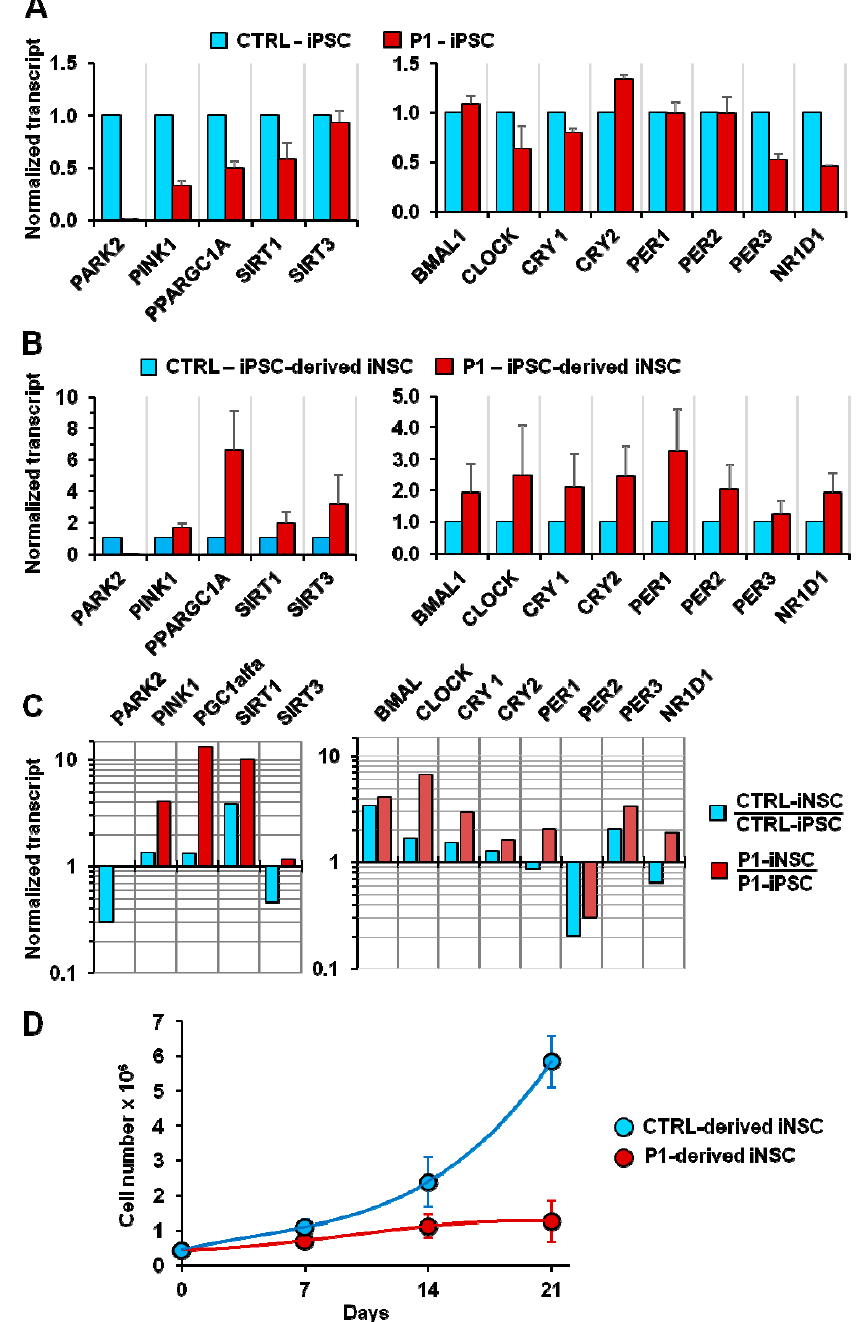
Figure 8. Transcription levels of mitochondrial quality control / biogenesis-related and core clock genes in induced pluripotent stem cells (iPSCs) ( A ) and in induced neural stem cells (iNSCs) ( B ). iPSCs and iNSCs were generated from normal (CTRL) and PD patient-derived (P1) fibroblasts as detailed in the Materials and Methods. The transcript levels of the indicated genes in P1-derived iPSCs / iNSCs were normalized to those of the CTRL-derived iPSCs / iNSCs. ( C ) Fold changes in the expression of the indicated genes in iNSCs as compared with the same in iPSCs. ( D ) Comparative growth curves of neurospheres generated from CTRL and P1 iPSCs. The bar values shown in ( A ) and ( B ) are means ± SEM of two independent measurements carried out in technical triplicate for each gene; the values in ( D ) are means ± SEM of three independent